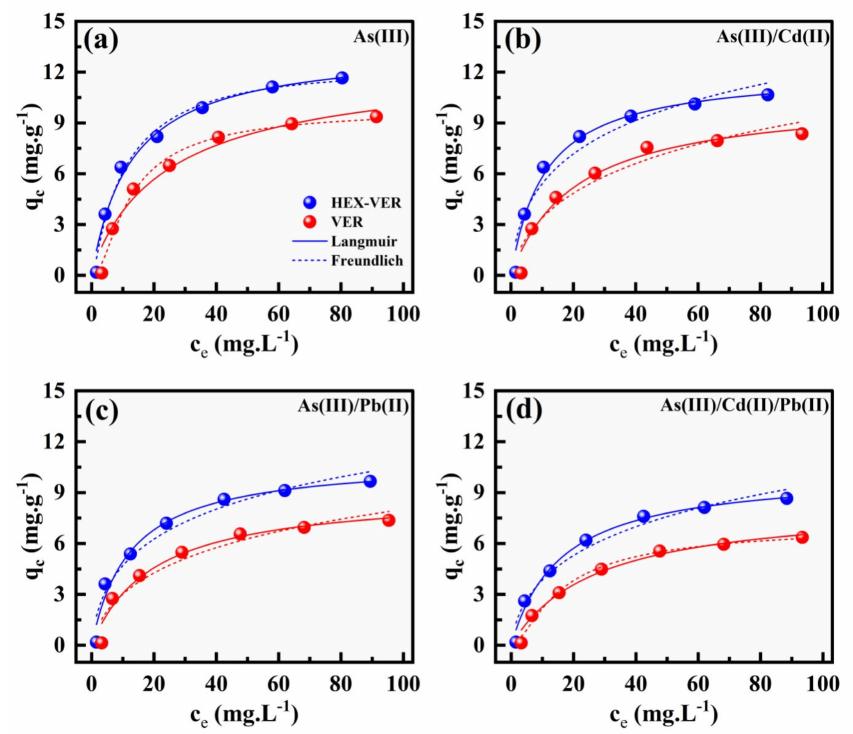
Figure 4. Effect of initial concentration and adsorption isotherms study of As(III) singular ( a ), in the presence of Cd(II) ( b ), in the presence of Pb(II) ( c ), and in the presence of Cd(II)/Pb(II) ( d ) on VER and HEX–VER; contact time, 1440 min; temperature, 30 ◦ C; pH,